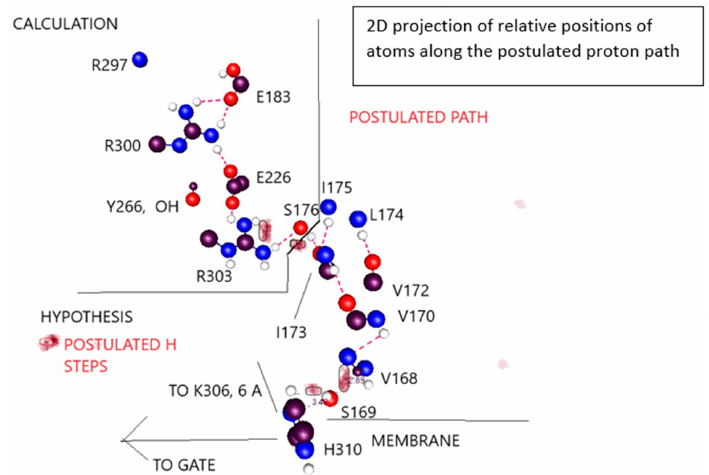
Figure 7. A postulated path for the protons from the calculated section in the upper left toward the gate, which would be in the lower left, off the diagram. Almost all atoms of the amino acids are omitted, but the two-dimensional projection of the geometry is suggested by the diagram, which shows key atoms for each amino acid, and backbone atoms for the hydrophobic residues. Residues, all hydrophobic, from the S1 helix are shown to indicate the geometry, but there is very likely to be water in the neighborhood, between the helices. Since the path is not perfectly defined, a smudge (red) is used to indicate approximate steps. On depolarizing the membrane, the proton would follow a path from the lower left, to the lower right, and then diagonally into the calculated region at the upper left. The S1 helix begins and ends nearest the residues at the ends of the path (R303 is near I173, and H310 is near the other end of the groups shown). It is encouraging that a very reasonable path was found. Atom colors: black = C, red = O, blue = N, white =